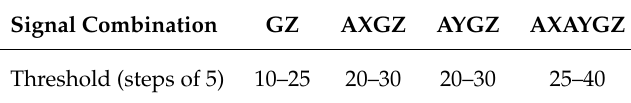
Figure 4. Template based on average of ( Left ) a three-dimensional accelerometer signal, ( Right ) a three-dimensional gyroscope signal. Signals AX, GX, and GY have a very low variation. Table 1. Euclidean dynamic time warping (eDTW) parameters.